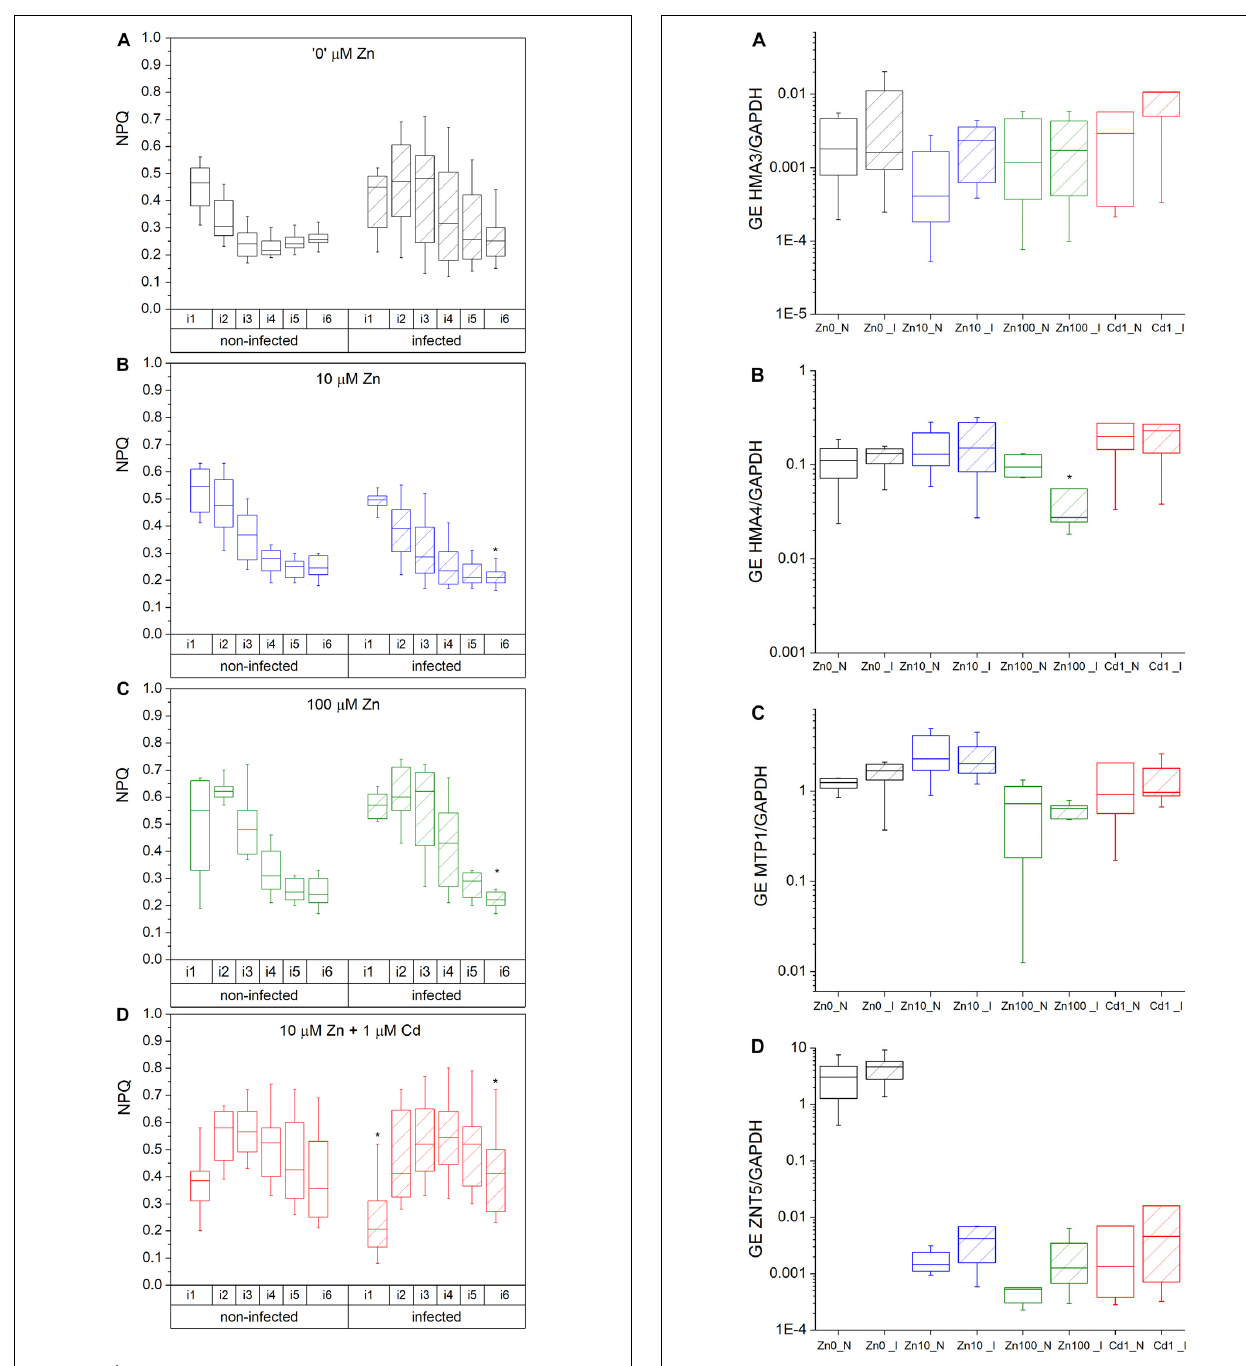
FIGURE 4 | Expression of metal transporter genes normalized to cytosolic GAPDH in the leaves of N. ochroleucum plants calculated according to Pfaffl. Zn0 (A) , Zn10 (B) and Zn100 (C) refer to Zn concentrations used in the treatments (‘0’ = 0.01, 10 and 100 µ M Zn), Cd1 (D) refers to a 1 µ M Cd + 10 µ M Zn treatment. N – non-infected – empty box plots. I – infected – box plots with stripes. The line presents the median value ( n = 6–8), the box shows the values between the 0.25–0.75 percentiles, and the bars show whiskers with 1.5 coefficient for outliers. Asterisks denote significant differences between infected and non-infected plants within the same Zn treatment according to the Mann–Whitney